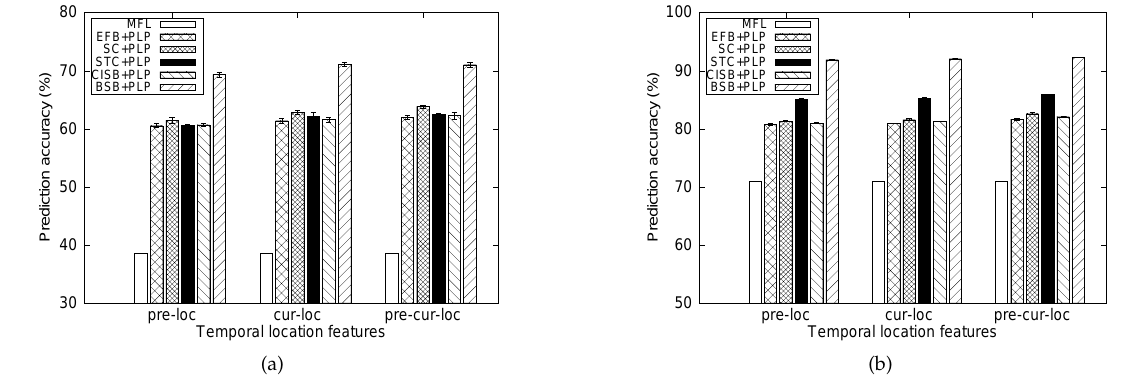
Figure 5. Effects of temporal location features on the prediction model in case of ( a ) the MIT dataset and ( b ) Dartmouth